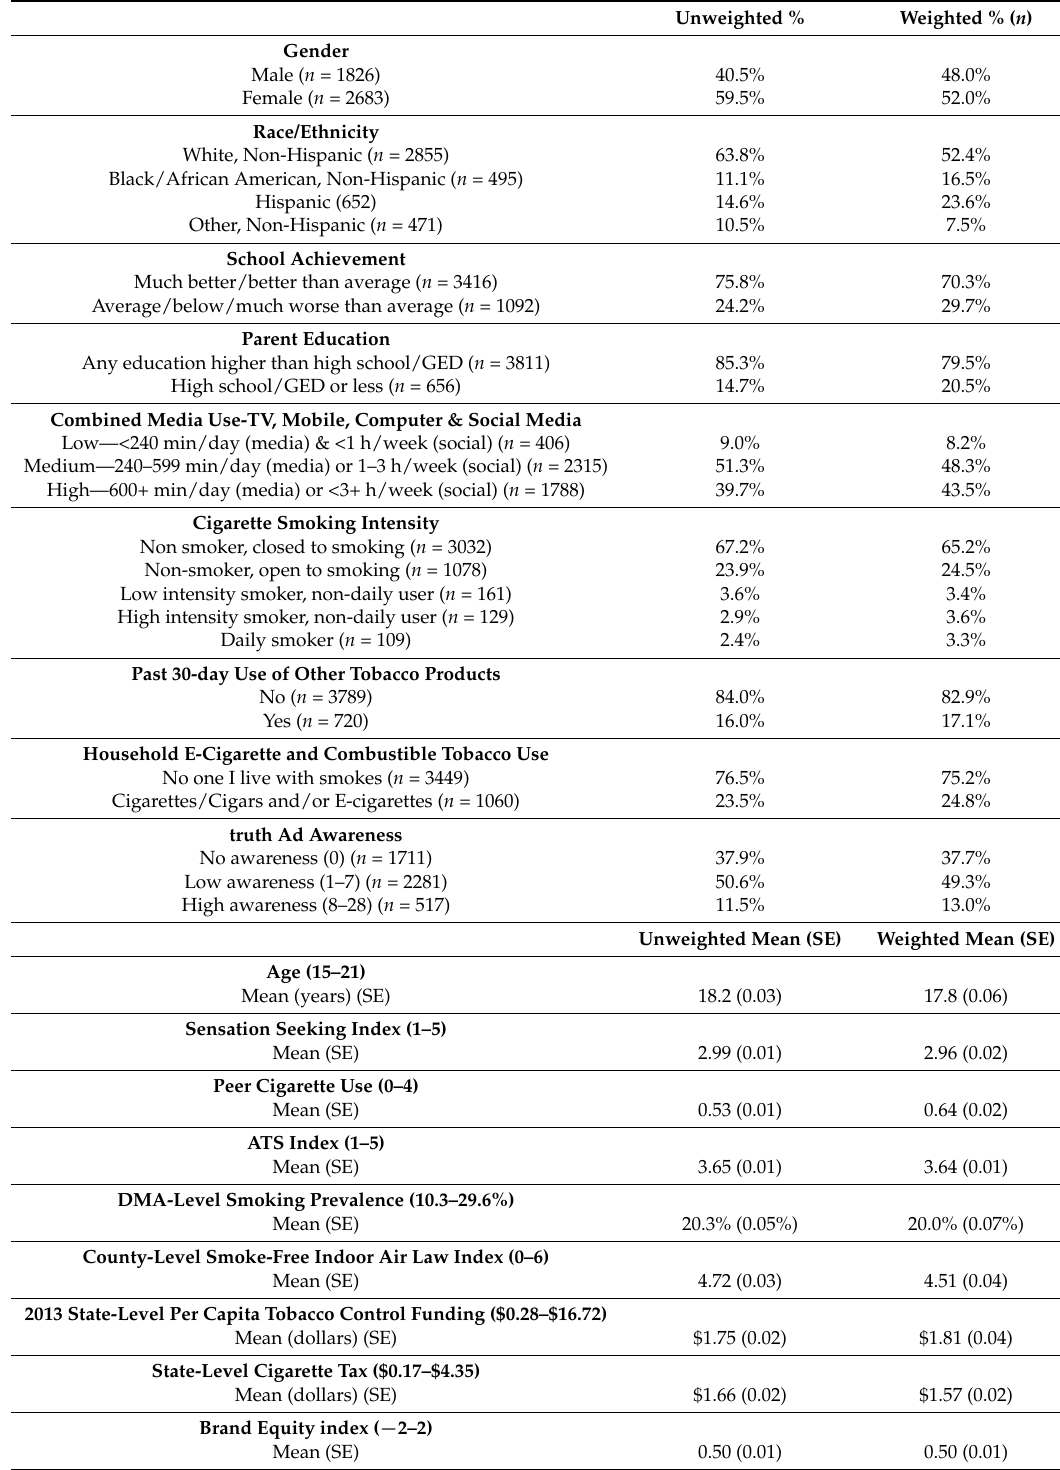
Table 2. Unweighted and weighted demographic/psychographic, health, ad awareness, and policy characteristics of study sample ( n =